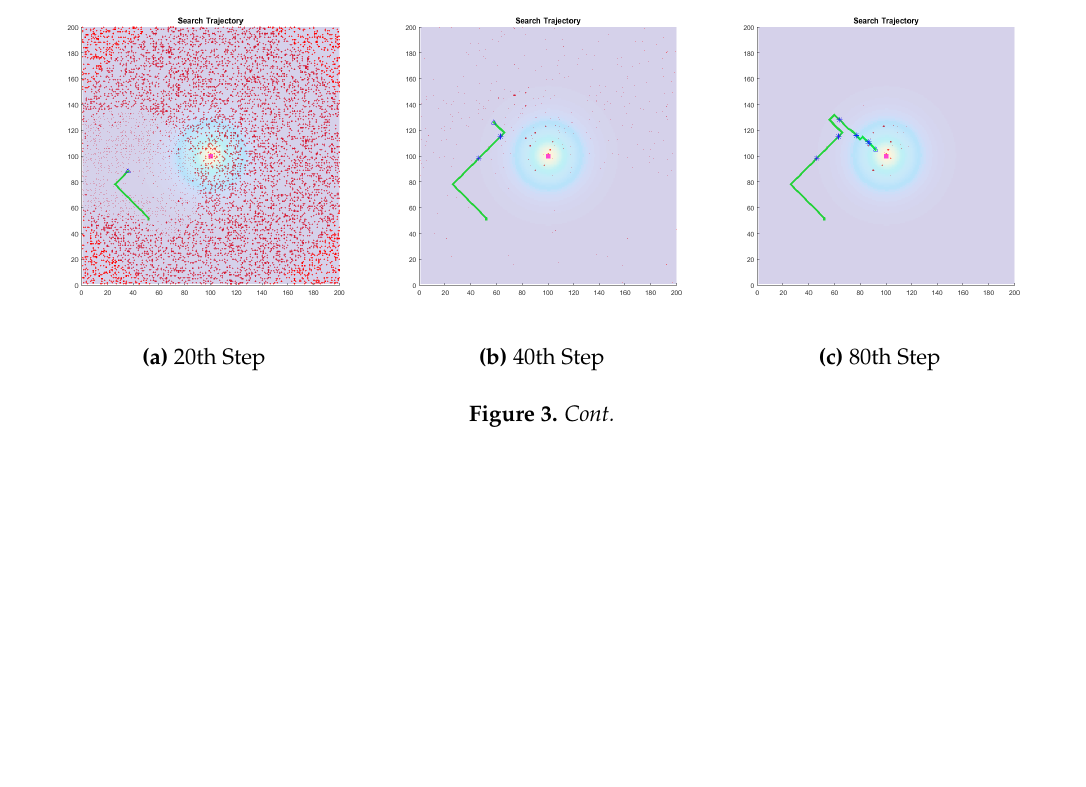
Figure 2. ( a – c ) The trajectory for a single robot searching for a source of chemical dispersion and the variation ( d ) of the entropy of the estimated probability distribution. The red plot indicates the change in entropy the robot predicts upon the move, while the blue plot is the entropy of the estimation calculated after performing the observation. About 10,000 particles are initially generated to estimate the probability distribution. The size of the particles does not represent the associated weight of the